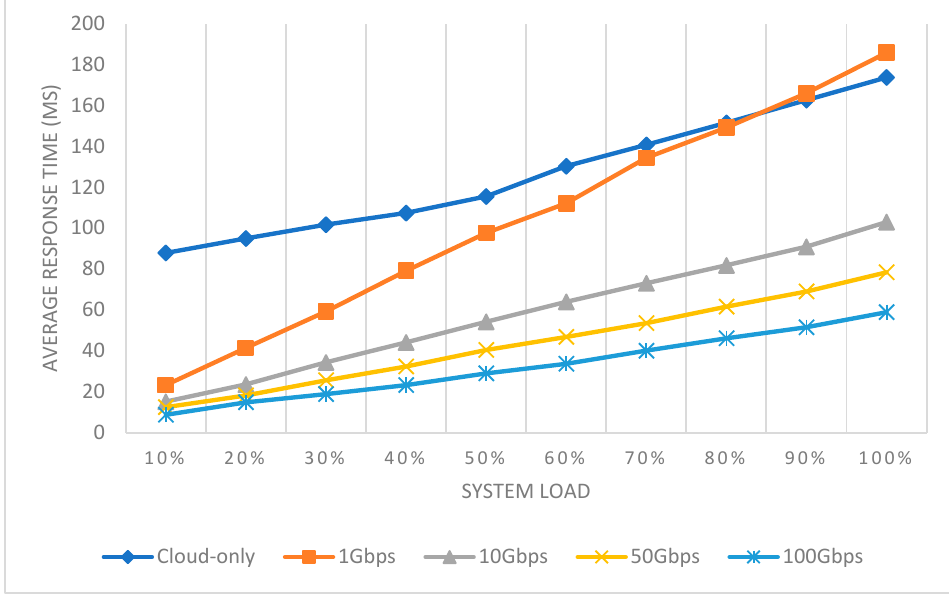
Figure 10. Cloud–edge schemes with 20% computing resources are available in the cloud.